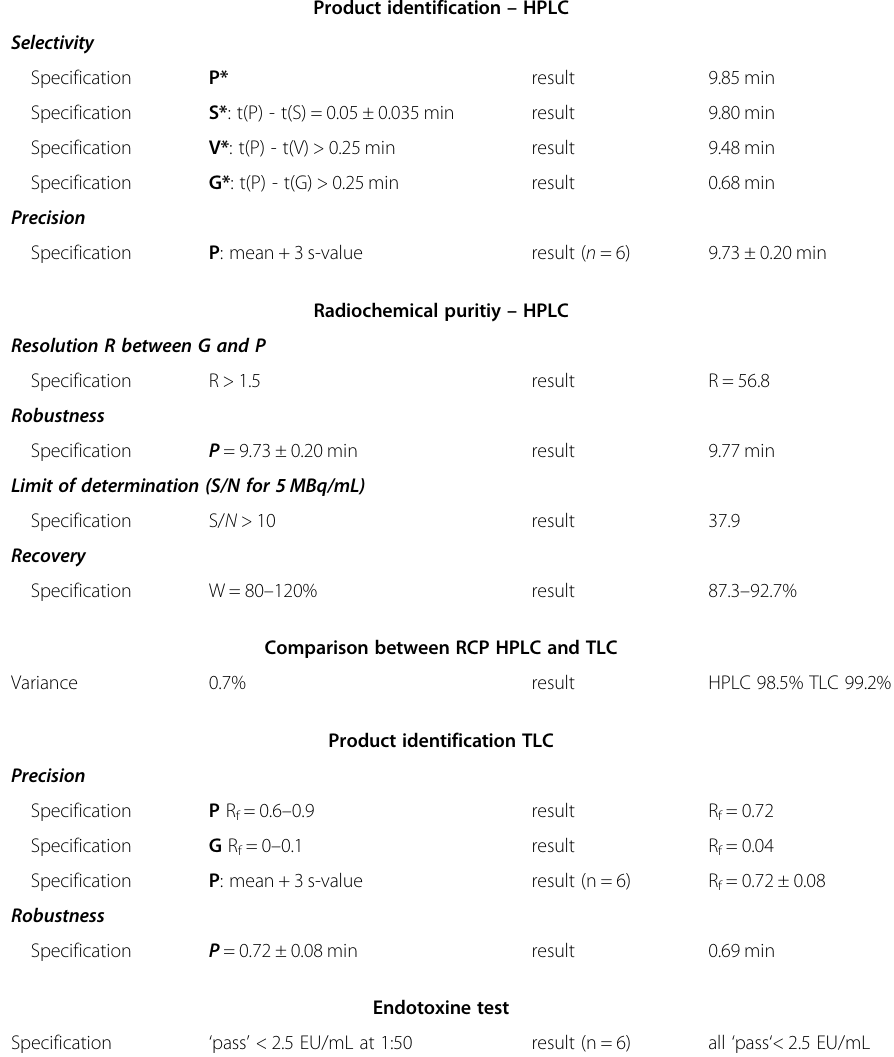
Table 1 Summary of the validation of the quality control methods fo [ 68